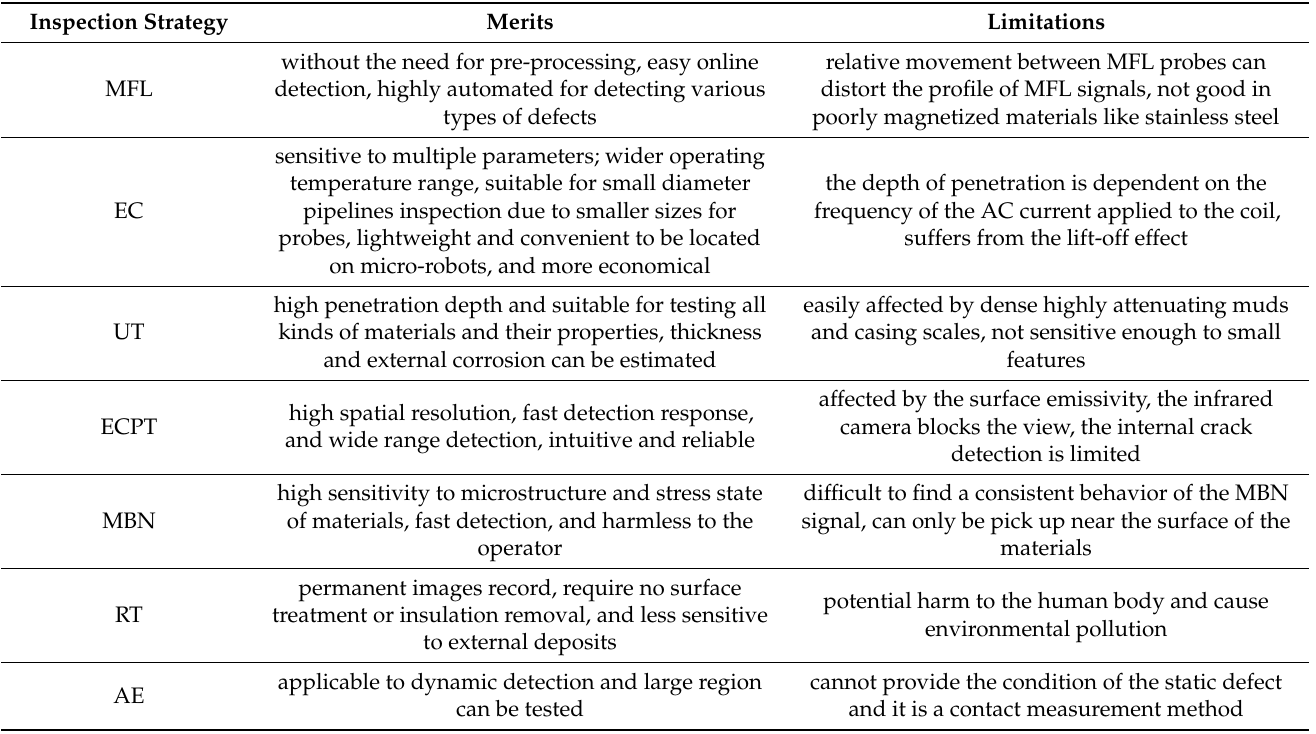
Table 3. Comparison of various technologies